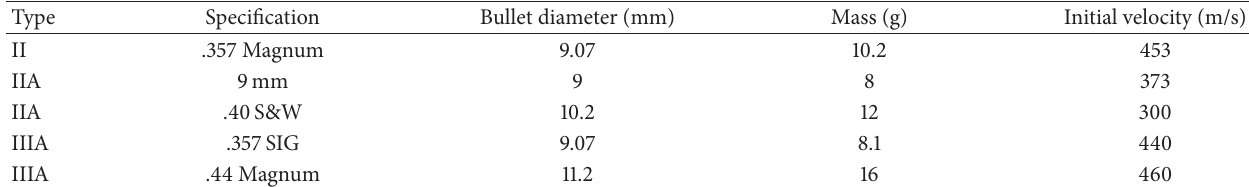
Table 7: Specifications of the different calibers used in the simulation.